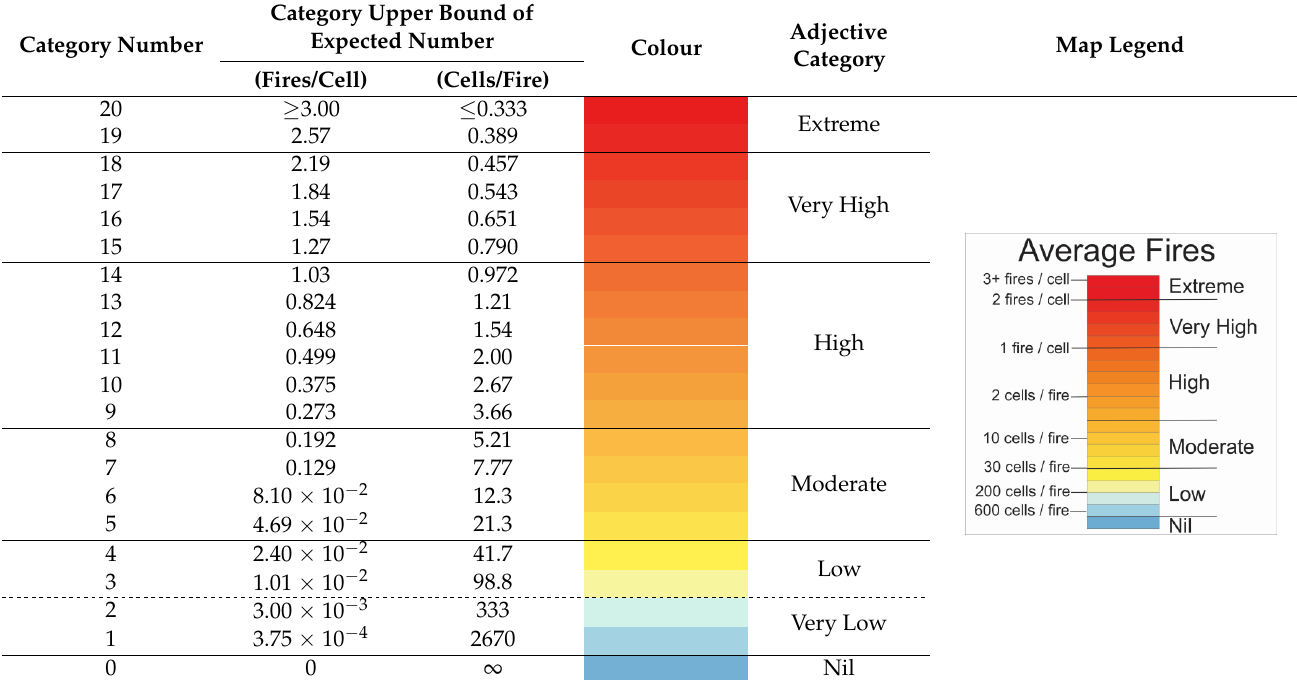
Figure 6. The original and unified fire occurrence prediction (FOP) classification scales. Because of order-of-magnitude differences in FOP, a separate scale was originally used for each cause: linear for lightning (black) and subjectively determined, irregular, nonlinear for human (blue). The unified scale (red) is a systematic, nonlinear one generated by a power function; a cube root in this